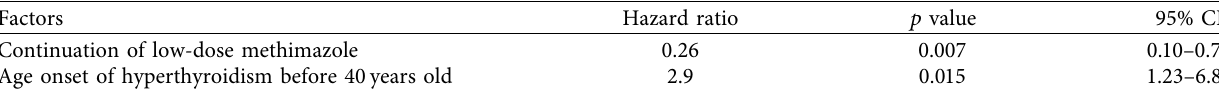
Table 4: Multivariate analyses of factors associated with recurrent hyperthyroidism in 173 Graves’ hyperthyroid patients who were eligible for analyses at the end of the